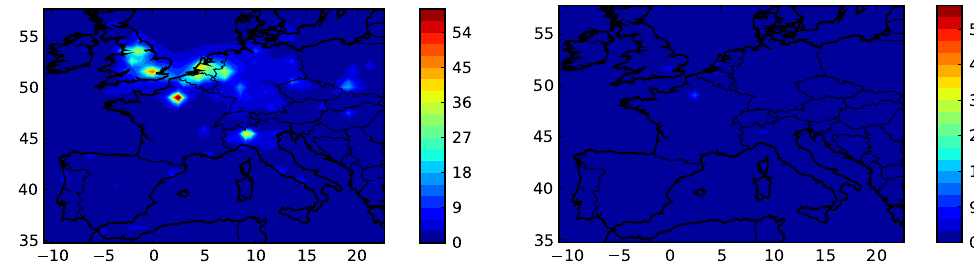
Fig. 8. Temporal average of NO map for reference model 5 (left) and for model 52 of the 101-member ensemble (right).